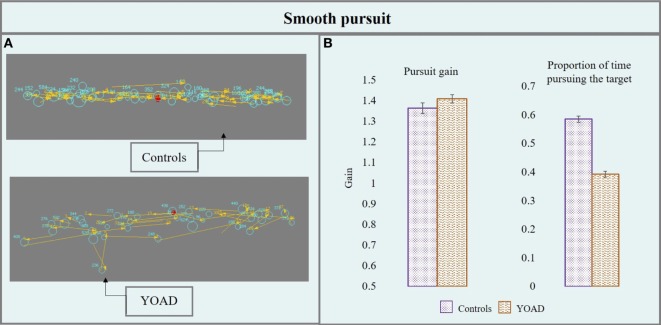
(A) Performance of a control and a young onset Alzheimer’s disease (YOAD) patient in the smooth pursuit task: light blue circles show fixations, yellow arrows indicate saccades, and red crosses represent target position. (B) Group means for controls and YOAD patients for the different task metrics. Error bars represent SE.